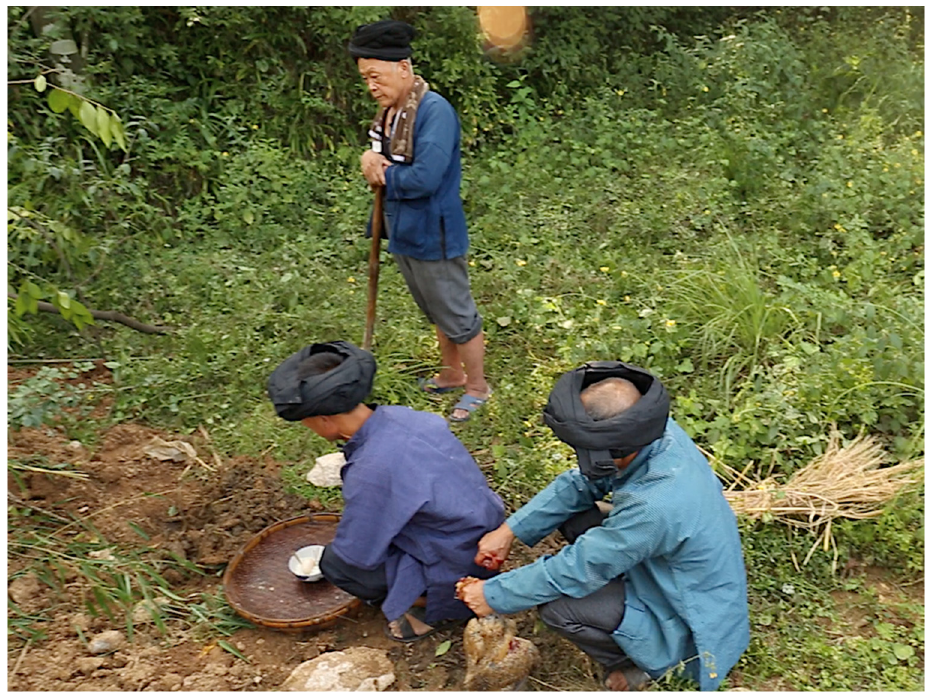
Figure 15. L to R: Badai Yang, Tian, and Changwu sacrificing a rooster in the woods near the family home. (Photo: Thomas Riccio).